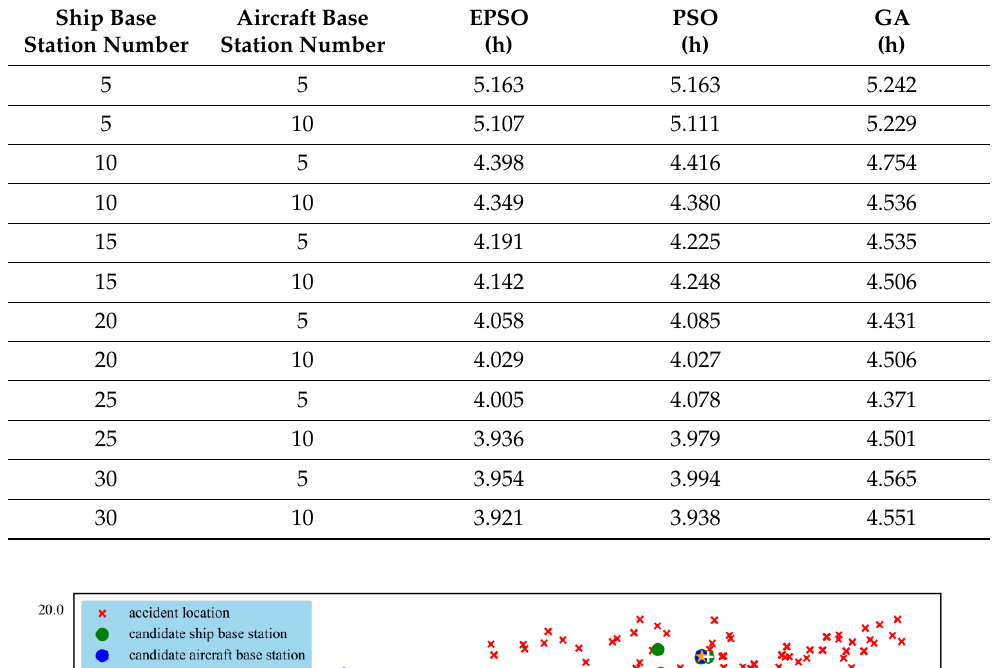
Table 3. Rescue time distributions with different ship and aircraft base station number.